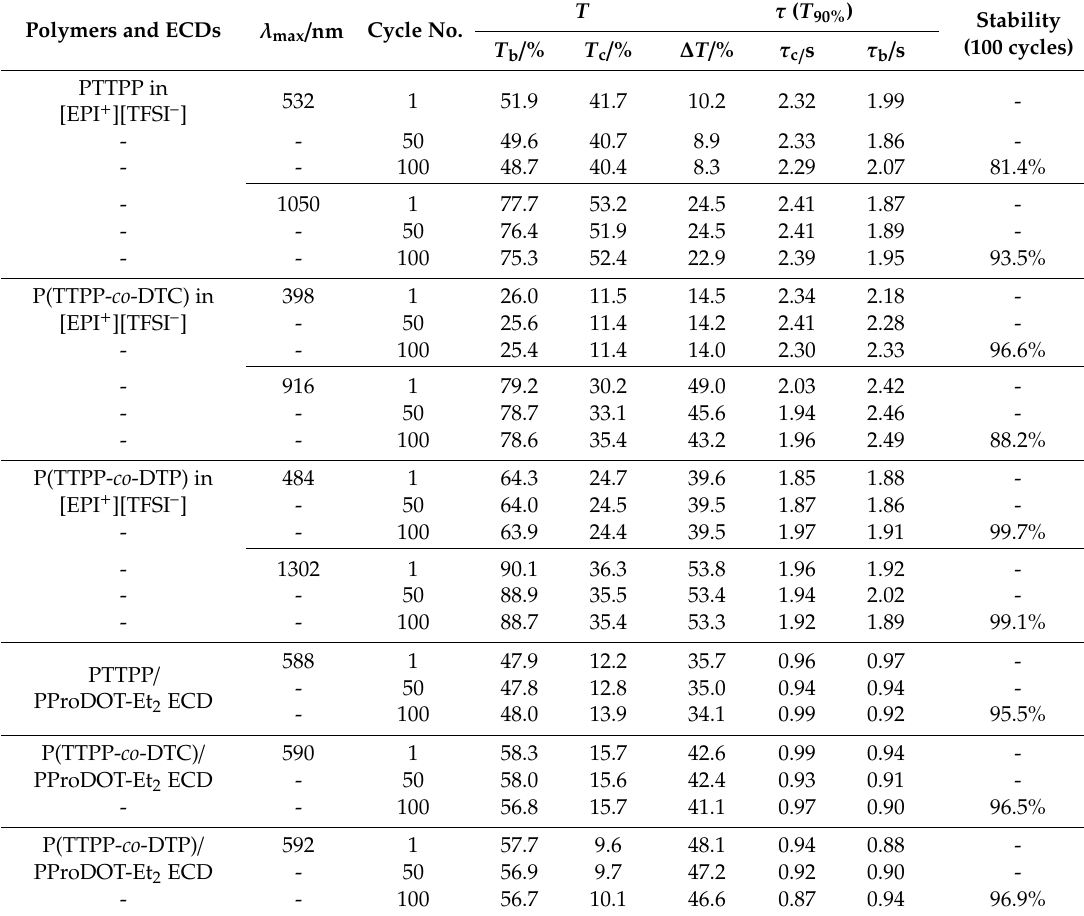
Table 3. Coloring-bleaching kinetics of polymer electrodes and ECDs. Polymers and